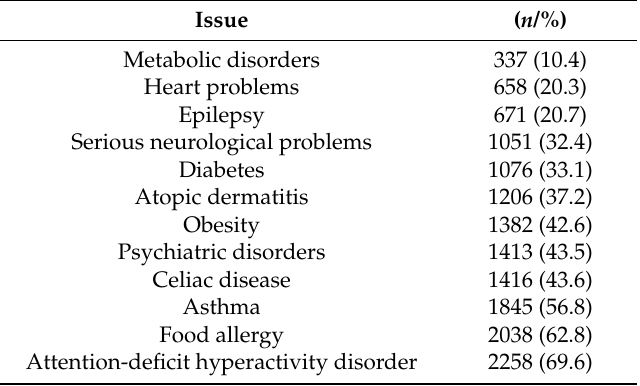
Table 2. Students health issues in the current course, as notified by